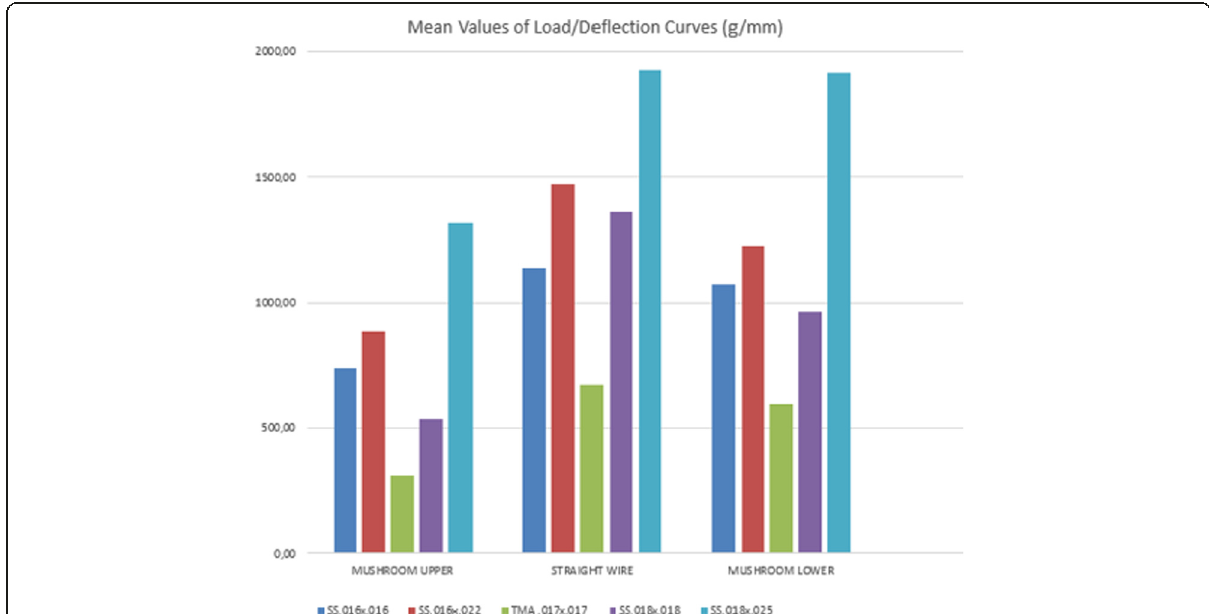
Fig. 5 Mean values of Load/Deflection curves of SS 0.016 × 0.016-inch, SS 0.016 × 0.022-inch, SS 0.018 × 0.018-inch, SS 0.018 × 0.025-inch and β -